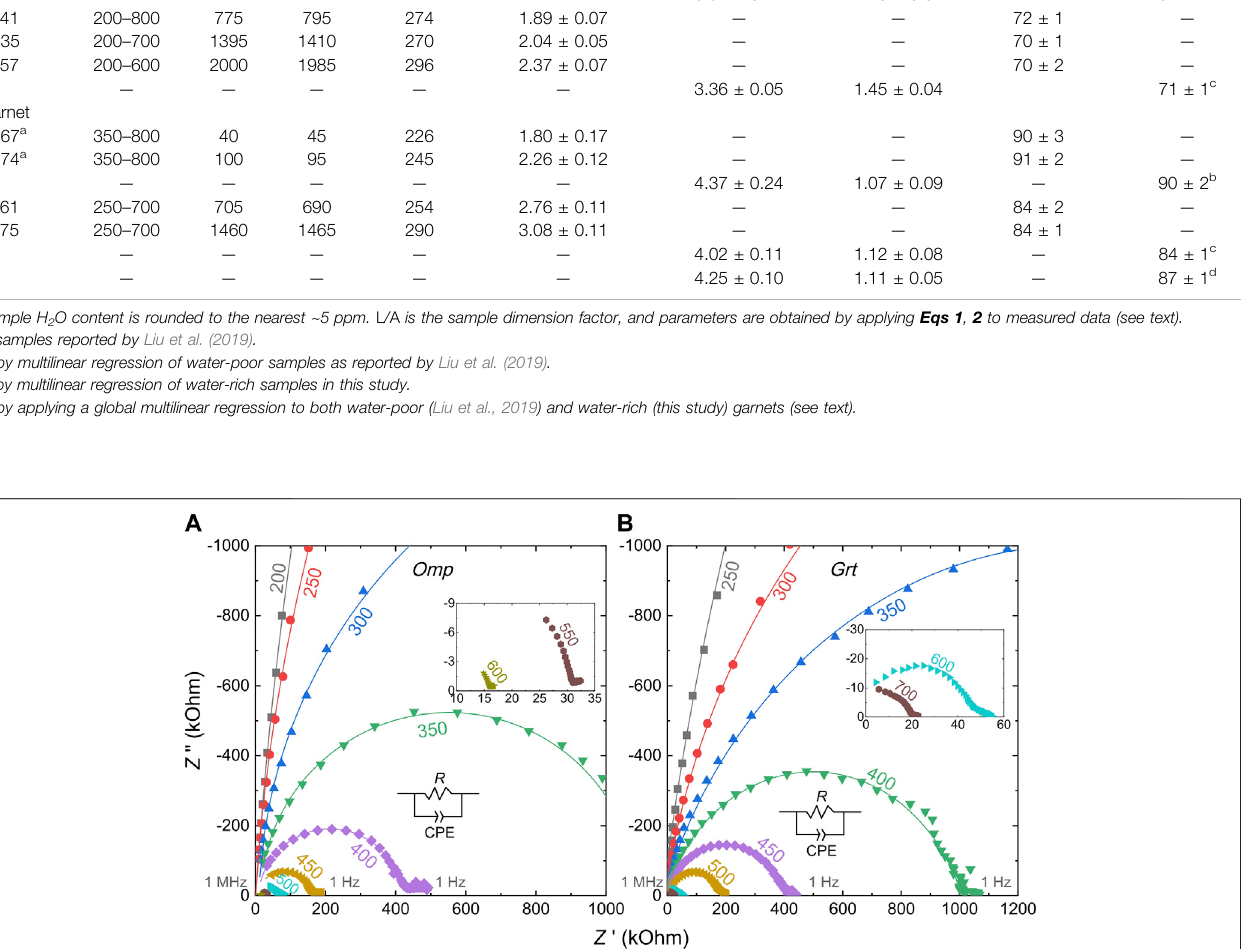
Frontiers in Earth Science |